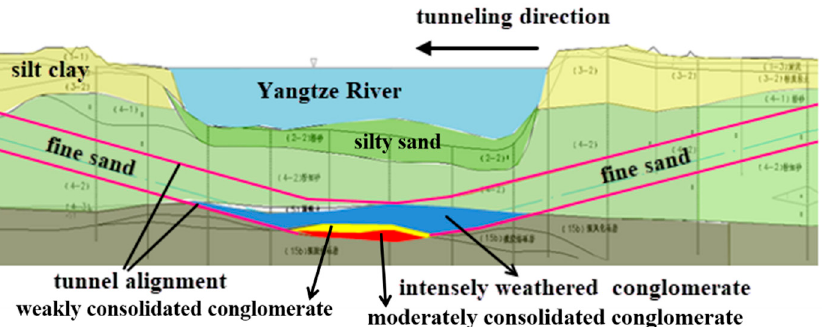
Figure 14. Longitudinal cross-section of the Wuhan Metro Line 8 Yangtze River Crossing tunnel.